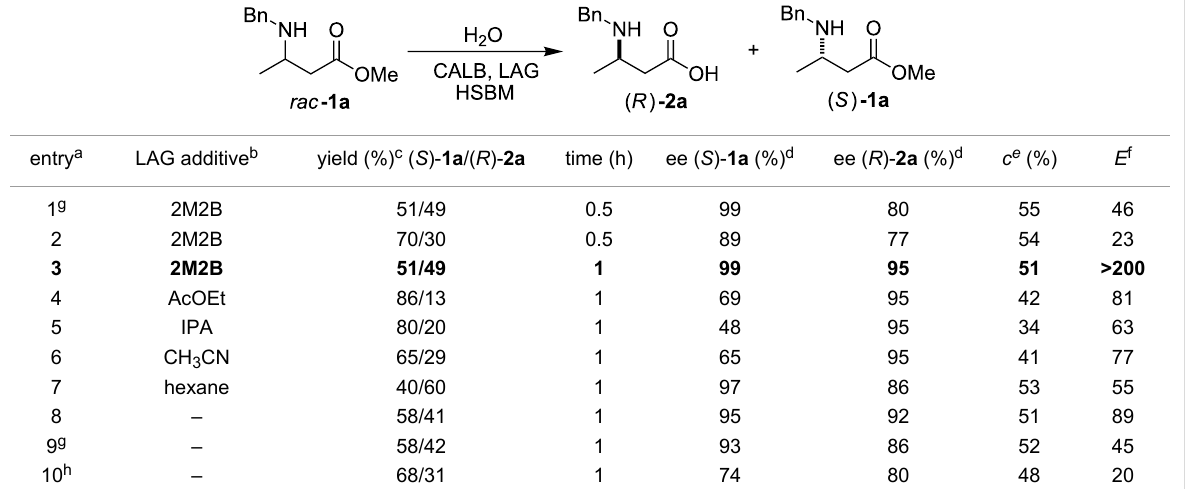
Table 1: Search of the best parameters in the enzymatic enantioselective hydrolysis of rac - 1a under ball milling.